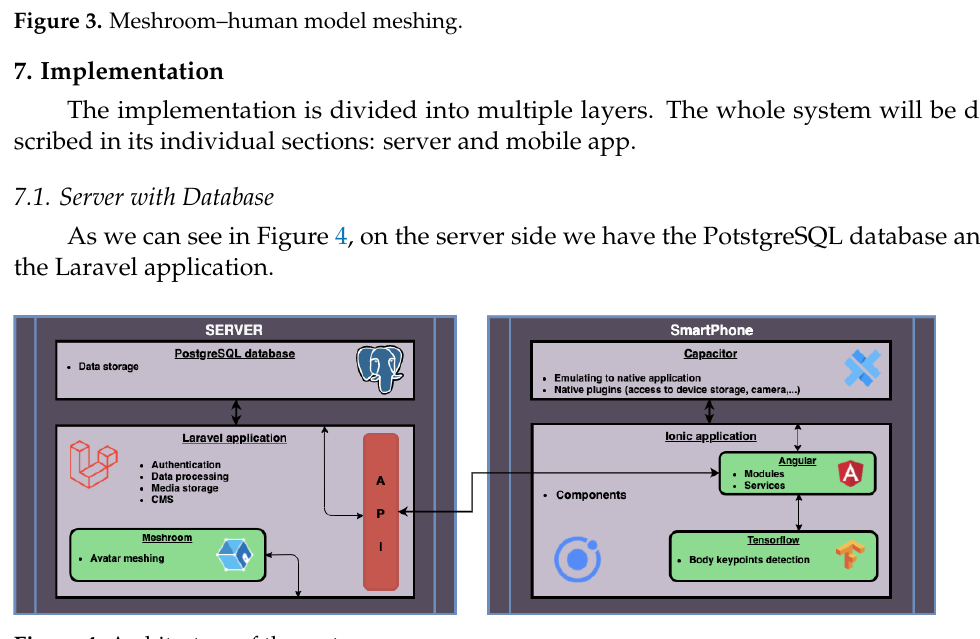
Figure 4. Architecture of the